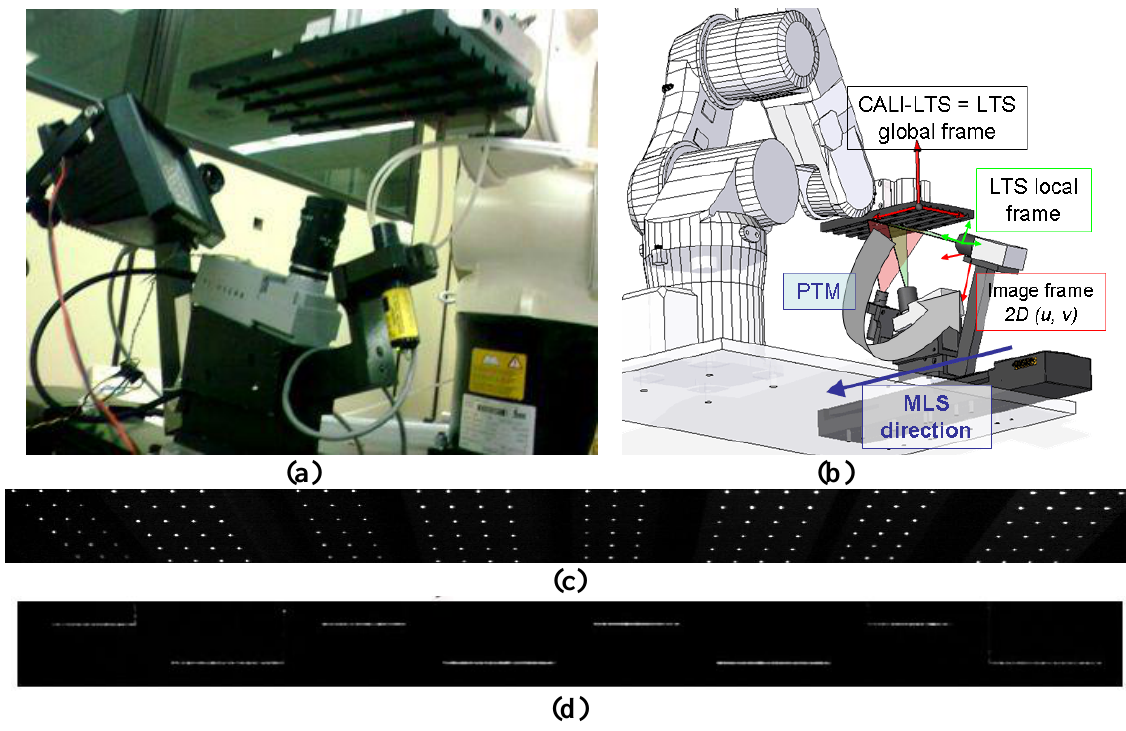
reference system in camera calibration. (c) Image taken for camera